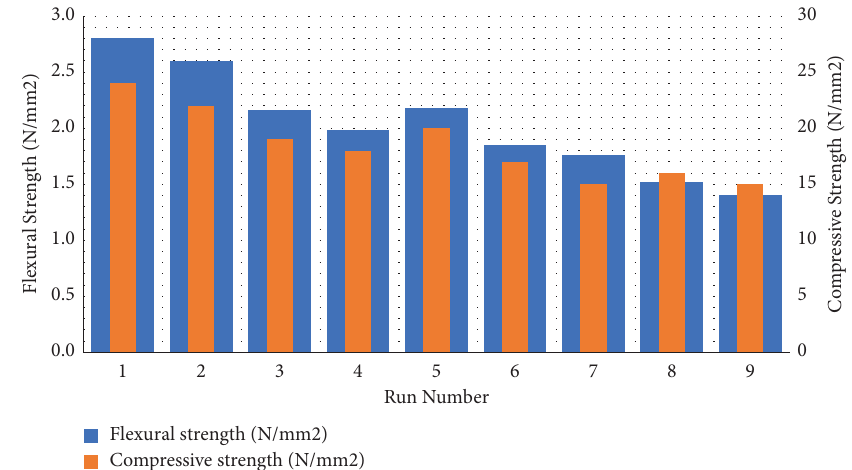
Figure 5: Flexural strength and compressive strength of RHA and PETp-modifed concrete.